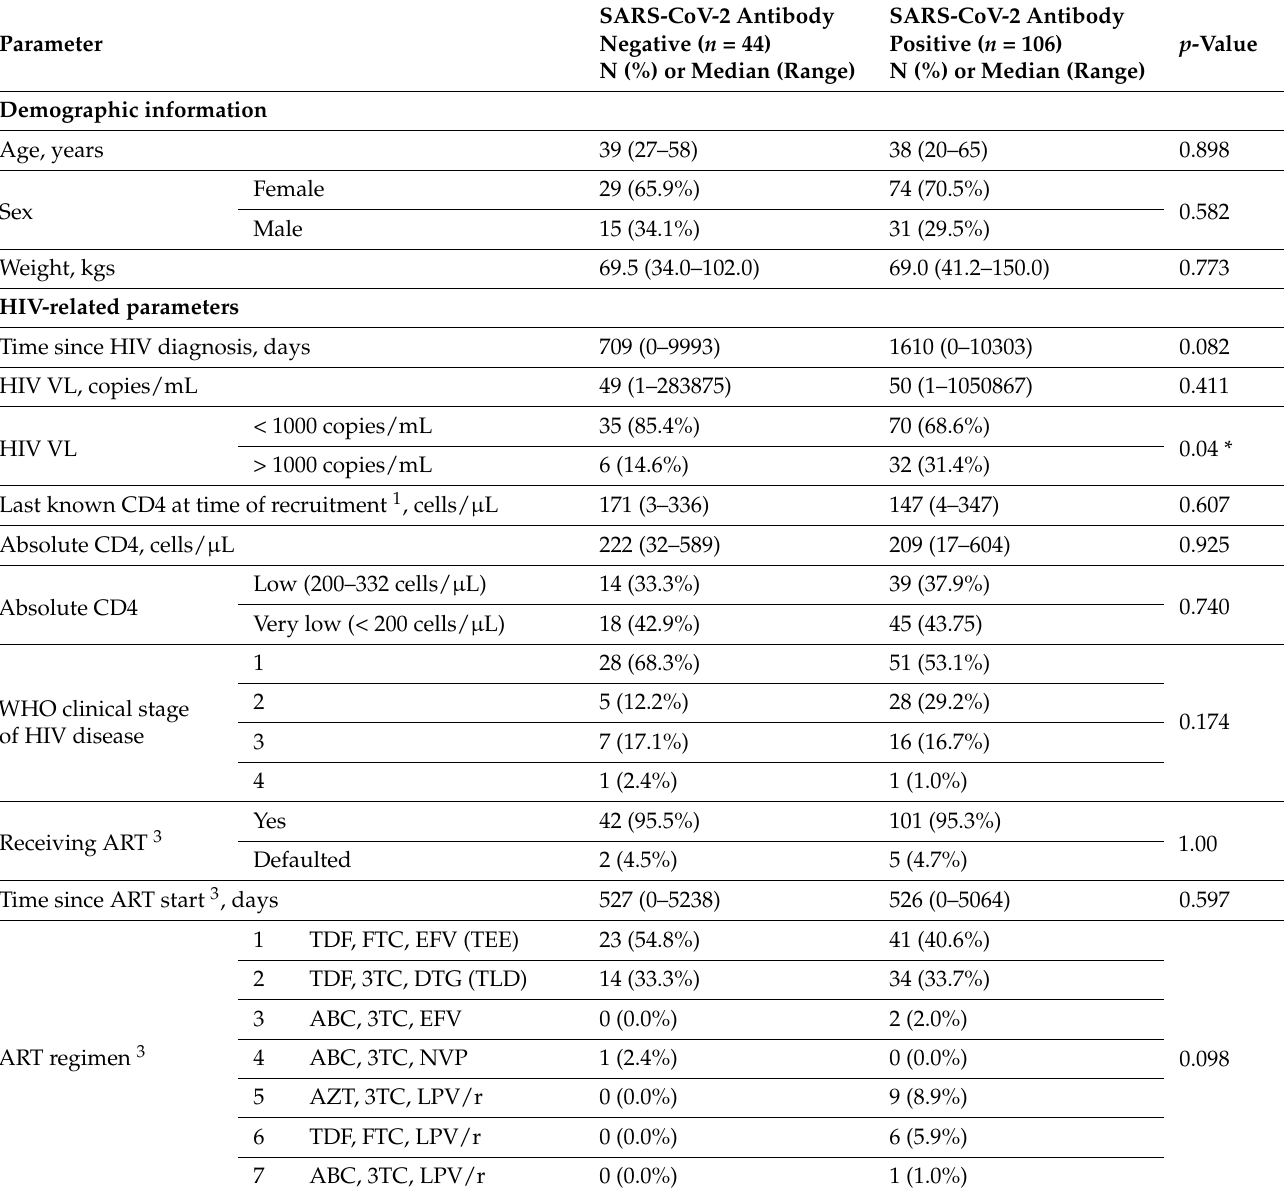
Table 2. Univariate analysis comparing clinical and virological parameters between patients who were negative and positive for SARS-CoV-2 antibodies. All patients ( n = 150) were HIV positive adults and were recruited with a last known CD4 count < 350 cells/ µ L. SARS-CoV-2 antibody positivity was detected by ELISA to IgG RBD and S1 (“Negative” indicates that a patient sample had an OD value below the assay cut-off for both IgG RBD and S1 ELISAs). Data are presented as number and percentage of total or median and range as appropriate. Participants with missing data are excluded per characteristic. p -values are by Mann–Whitney U test for continuous variables and Chi-square test or Fisher’s Exact test for categorical variables as appropriate. p < 0.05 is considered significant and indicated with